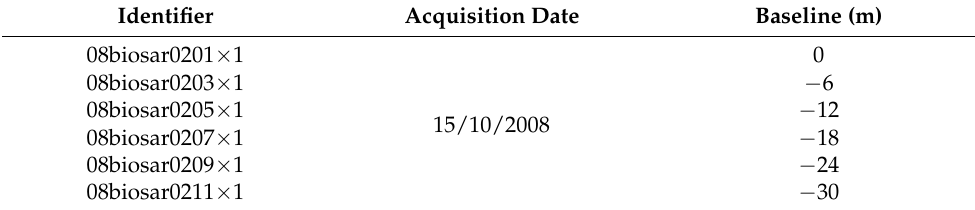
Table 5. The baseline information for the InSAR